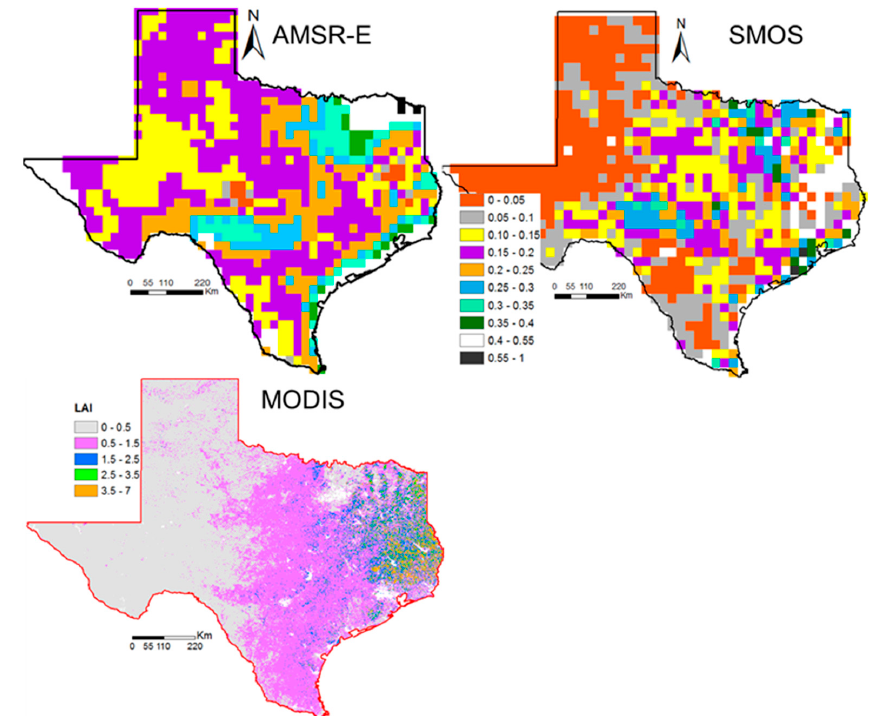
Figure 5. Soil moisture distributions for selected wet day (22 April 2011) across the state of Texas in the 2011 dry year.